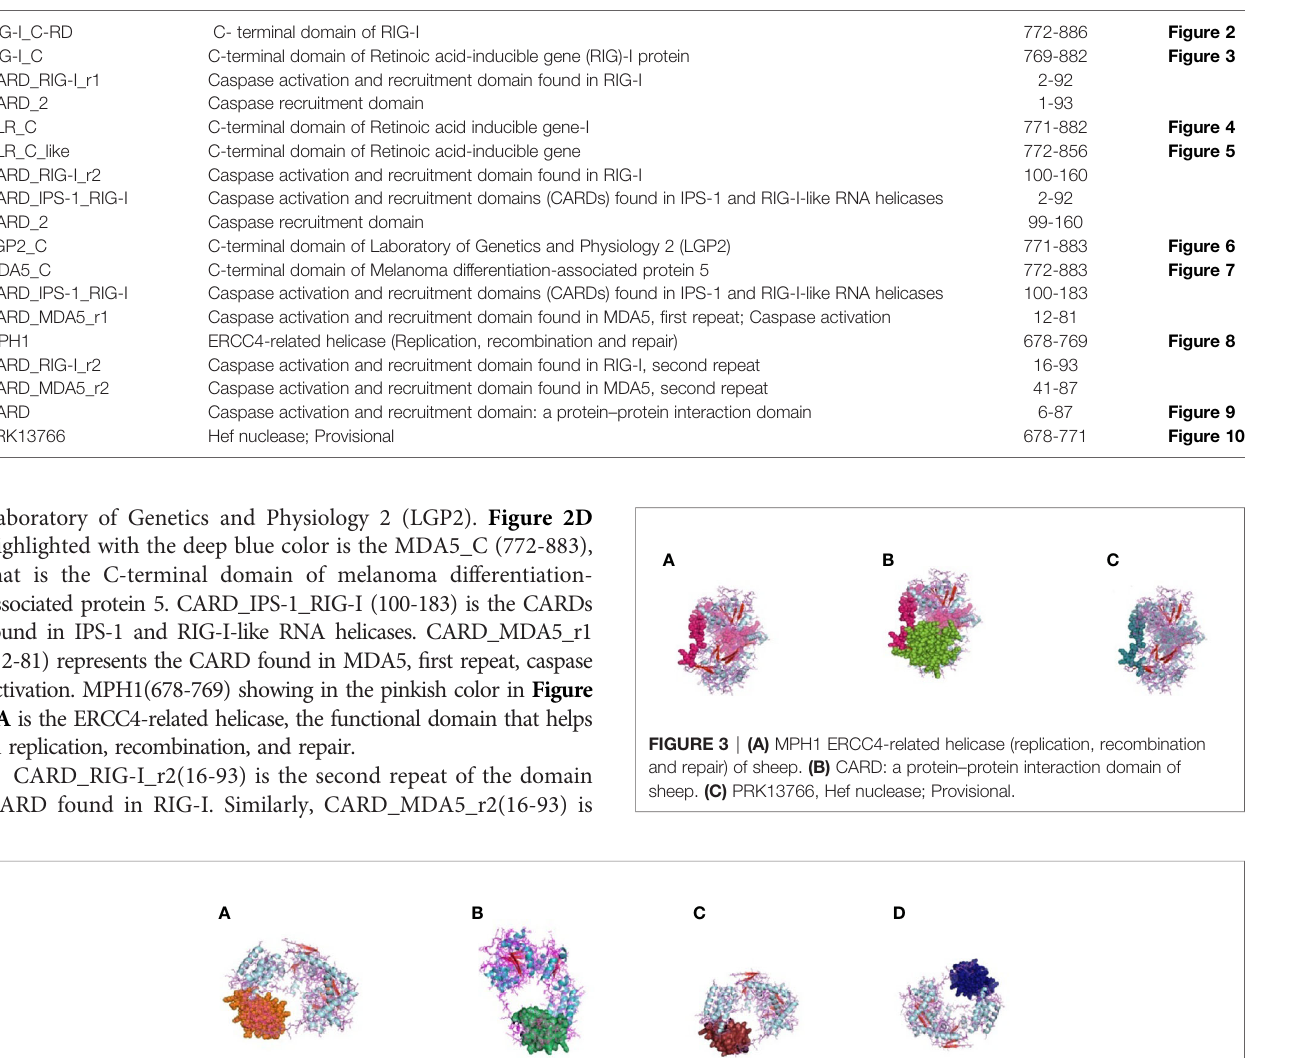
TABLE 4 | List of the important domains of RIG-I of sheep assessed through in silico